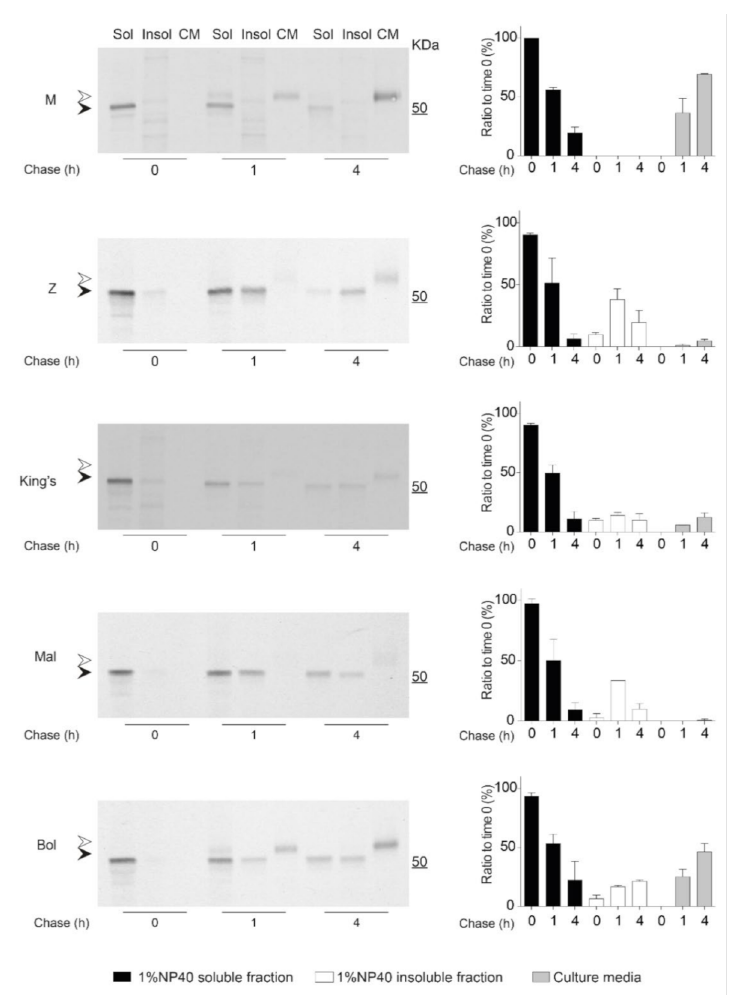
Figure 5. Kinetics of intracellular accumulation and secretion of AAT variants. Hepa 1.6 cells were transfected with the AAT variants as indicated. After 48 h of expression, the cells were labelled for 10 min with 35 S-Met/Cys and chased for the indicated times. Culture media were collected, and cells were lysed in 1% v / v NP-40 buffer for preparation of the soluble and insoluble intracellular fractions. All samples were immunoprecipitated with an anti-AAT polyclonal Ab (Dako). Samples were resolved in a 4–12% w / v acrylamide SDS-PAGE and detected by autoradiography. White and black arrowheads indicate the complex and high-mannose glycosylated forms of AAT, respectively. Autoradiograms from two independent experiments were quantified by densitometry to determine AAT levels, using the Image Studio Lite software (LI-COR Biosciences, Cambridge, UK). Graphs show mean ± standard error of the mean of radioactive AAT normalized to the t = 0 sample for each variant ( n =